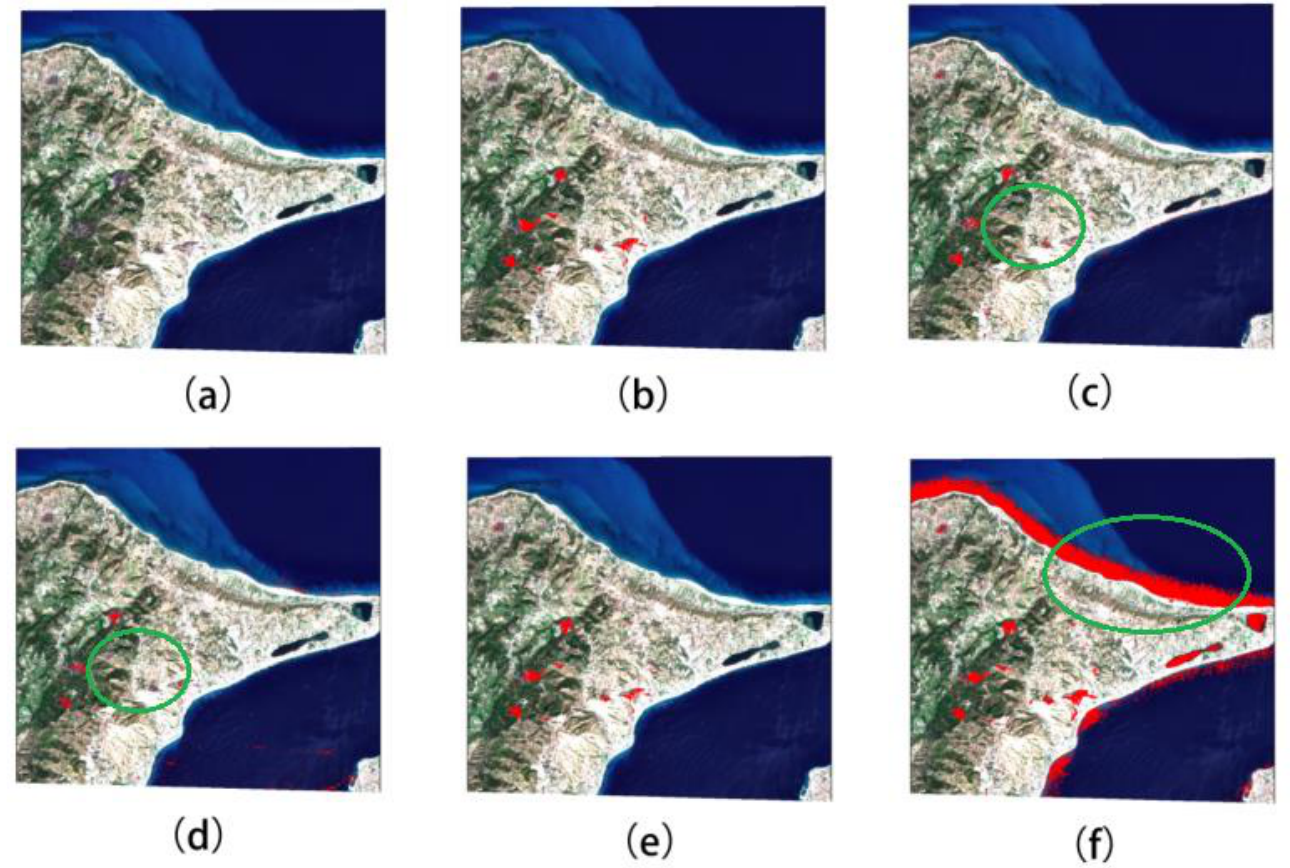
Figure 9. Display of Sentinel-2 image at Sicily Island and associated image features derived from different spectral indices. ( a ) False color image (composite bands 12-8A-4); ( b ) NBR+; ( c ) BAI; ( d ) MIRBI; ( e ) ABAI; ( f ) MNBR. (Note omission errors can be found in highlighted areas with green circles)